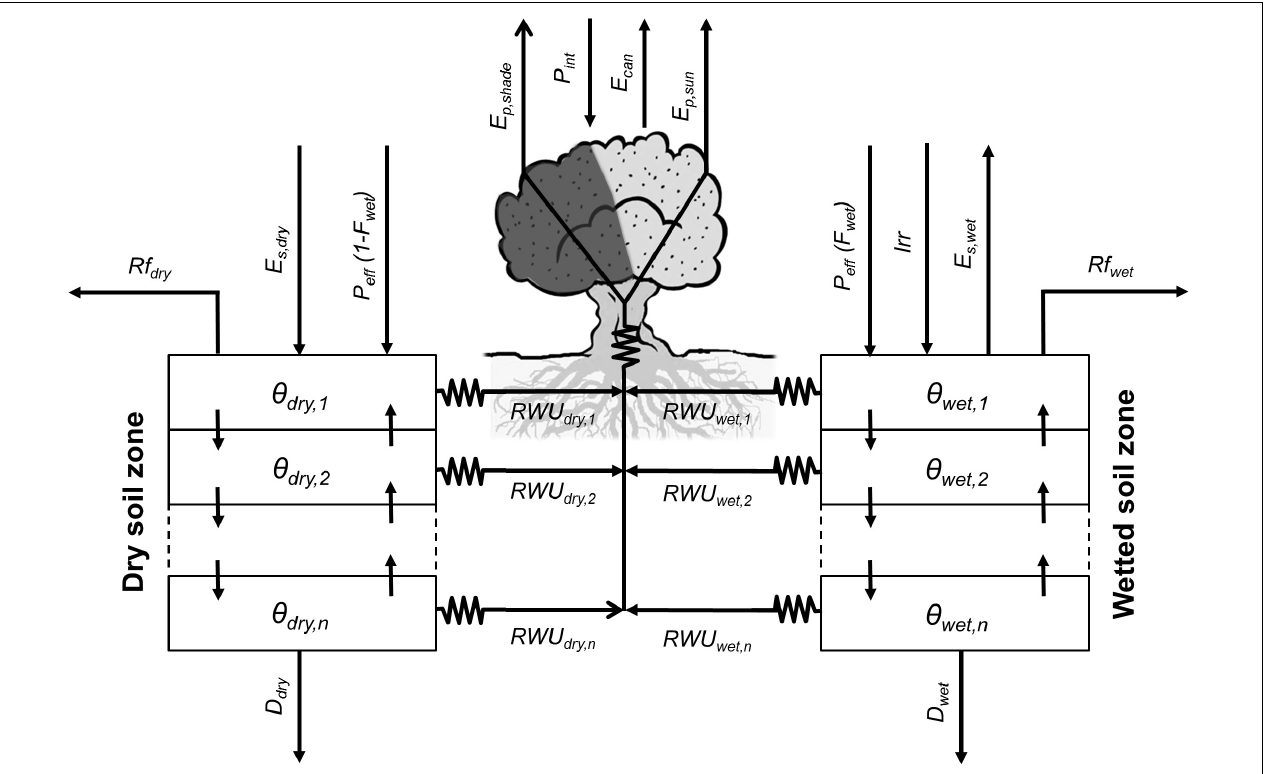
FIGURE 1 | Relational diagram of the water balance component, highlighting the processes simulated. Solid arrows represent fluxes of water. In OliveCan, the water balance is solved separately for two soil compartments (i.e., dry and wetted soil zones), as irrigation ( Irr ) is applied to only one of them. For each soil zone, soil water content (i.e., θ dry and θ wetted ) are updated every day after calculating the fluxes of effective precipitation ( P eff , dry and P eff , wetted ), runoff ( Rf dry and Rf wetted ), drainage ( D dry and D wetted ), water redistribution between the different soil layers, soil evaporation ( E s , dry and E s , wetted ) and root water uptake ( RWU dry and RWU wetted ). Direct evaporation of rain water intercepted by the canopy ( E can ) is also